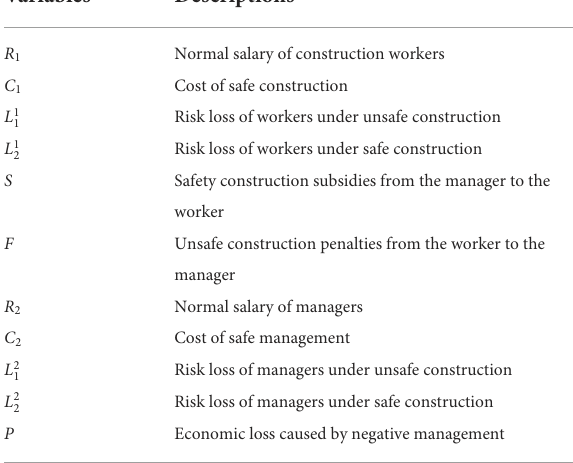
TABLE 1 Variables symbol